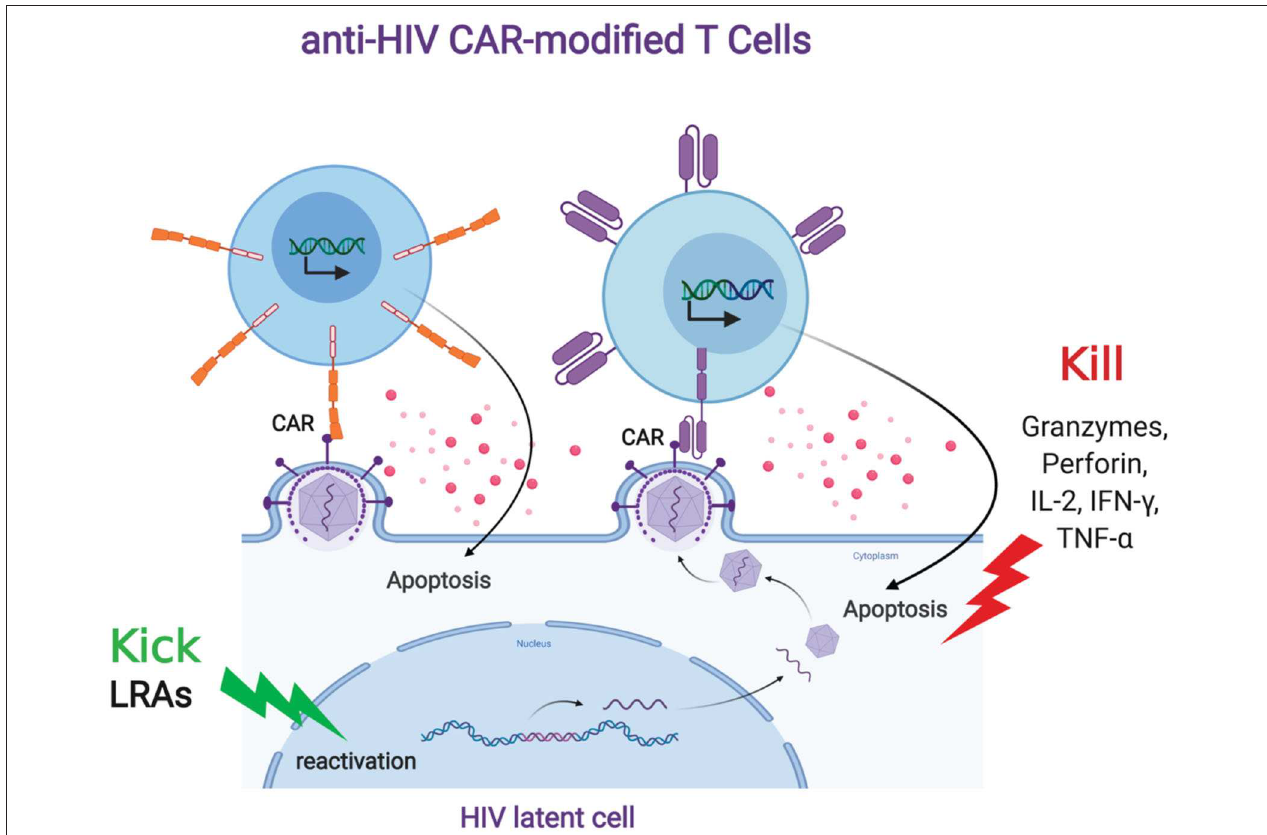
FIGURE 2 | Anti-HIV CAR modified T cells and the “Kick and Kill” strategy to eliminate HIV latently infected cells. The “kick” strategy uses LRAs to induce HIV transcription, protein expression, and virion production. The CD4 (top left, orange) or antibody (top right, purple) based CAR engineered T cell targets an HIV binding site on a viral particle on the cell surface of a reactivated reservoir cell (bottom). Upon binding, the CAR modified T cell will release granzymes and cytokines to “Kill” the HIV infected cells.